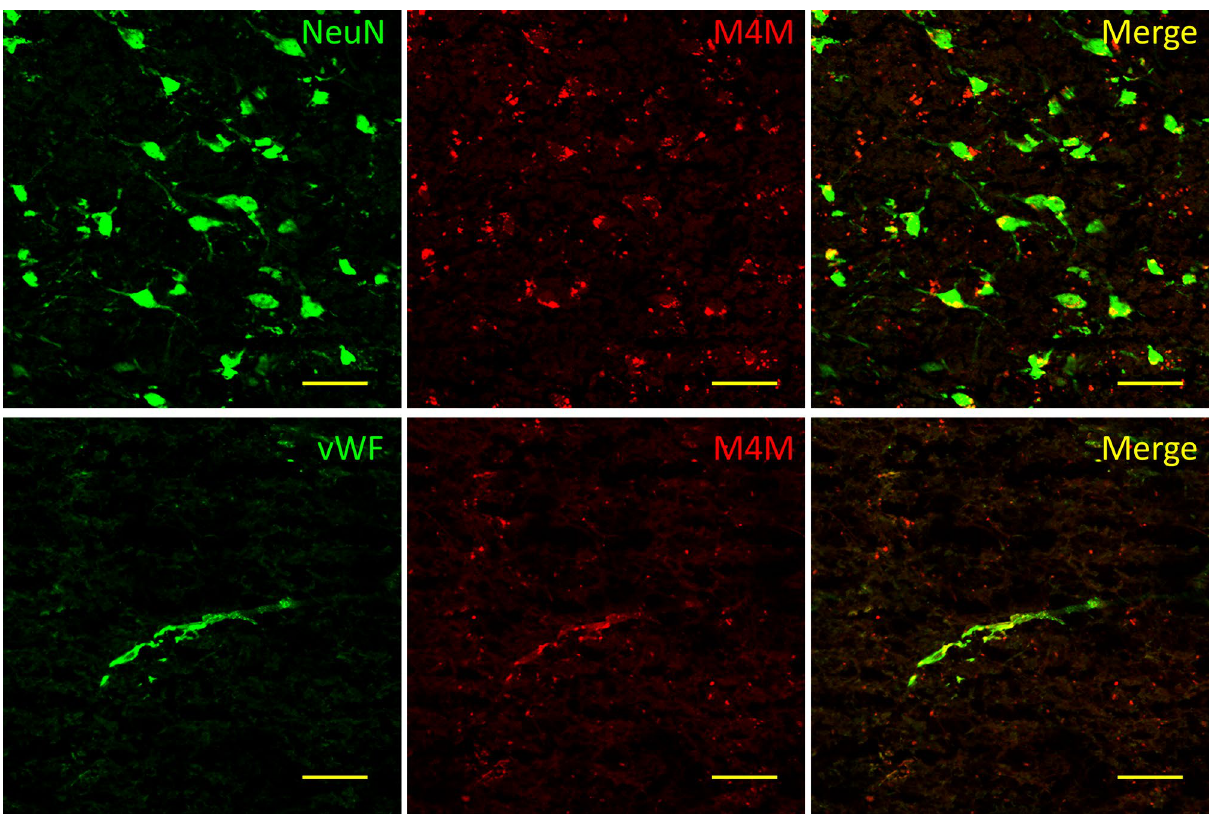
Figure 7. Immunofluorescent staining of human stroke brain tissues. M4M was used to stain human TRPM4 with neuronal marker NeuN and vascular marker vWF. Scale bars: 50